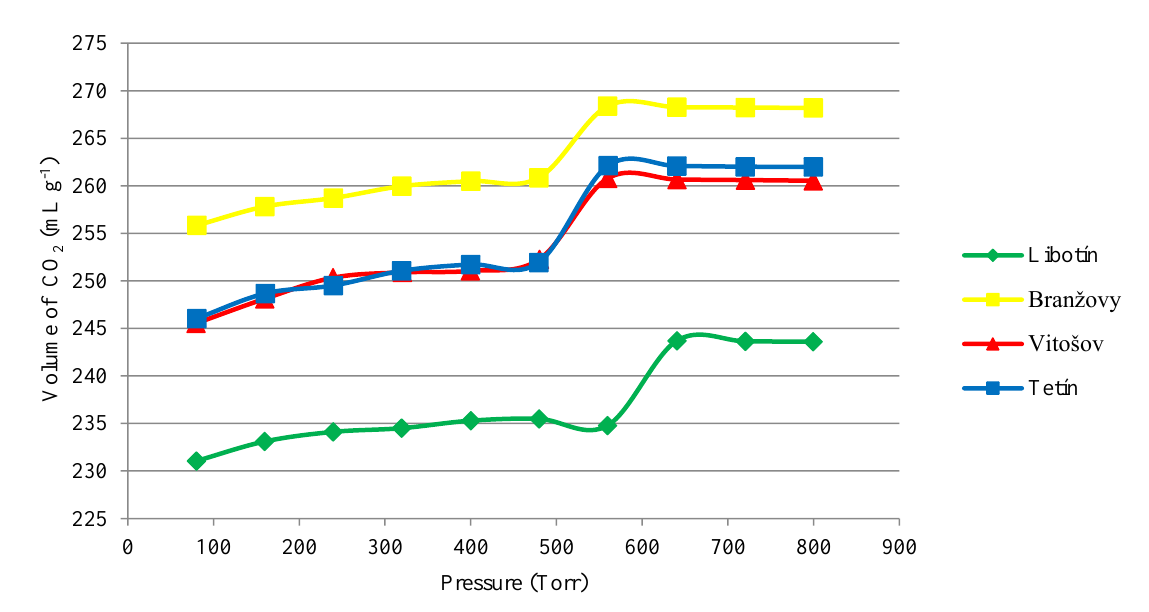
Figure 10. Volume of carbon dioxide used for chemisorption.